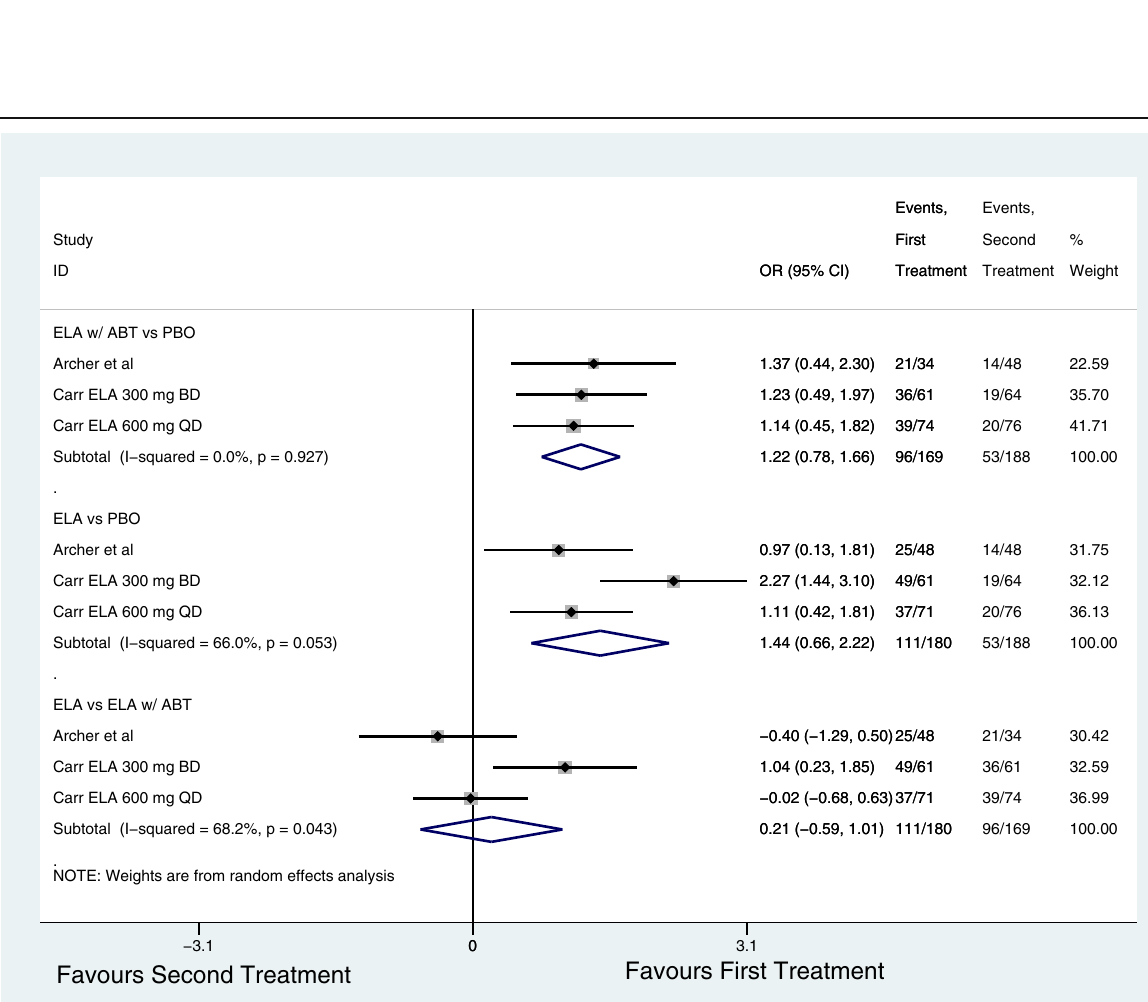
Fig. 4 Forest plot comparing across interventions the number of women with ≥ 1 g/dL increase in hemoglobin levels after